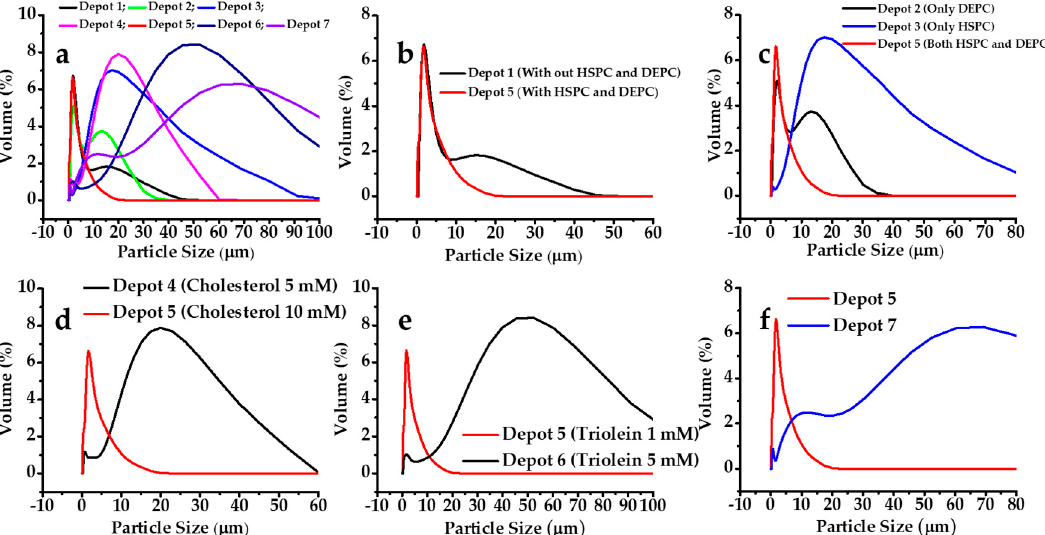
Figure 3. Effects of the lipid composition on the particle size of MVLs: ( a ) depots 1–7; ( b ) depots 1 and 5 (with or without HSPC and DEPC); ( c ) depots 2, 3, and 5 (alone or with a combination of HSPC and DEPC); ( d ) cholesterol 5 and 10 mM; ( e ) triolein 1 and 5 mM; and ( f ) DSPG-Na 1 and 5 mM.